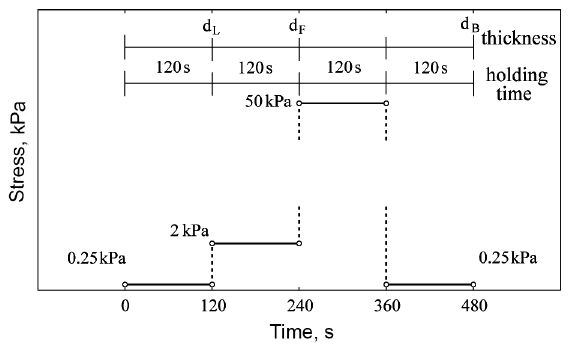
Fig. 1. Scheme of variation of thickness of lightweight compo-